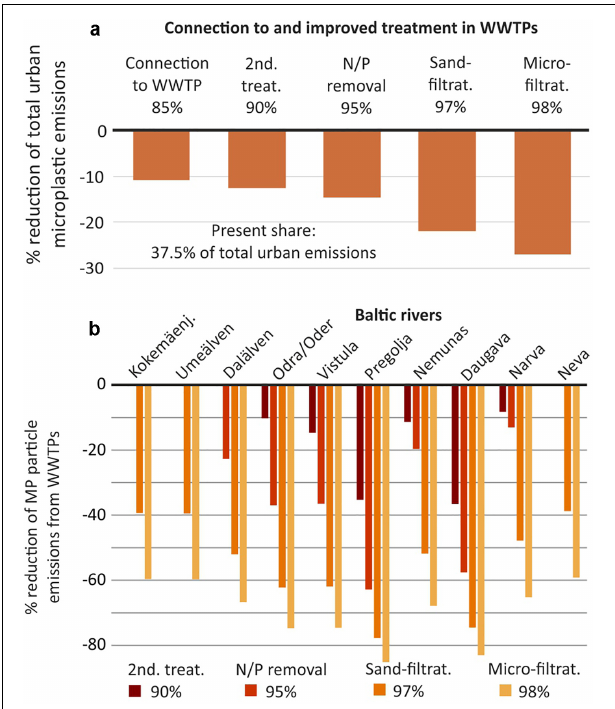
FIGURE 5 | (a) Relative micro-plastic particle emission reductions (floating and sinking fraction, size class 20–500 µ m) resulting from the assumption that all sewage water in the Baltic catchment is processed in a basic treatment plant (WWTP) with a micro-plastics cleaning efficiency of 85%, that all are connected and the WWTPs possess a secondary treatment with a 90% cleaning efficiency and that a better treatment is applied, reducing the micro-plastics loads by 95, 97, and 98%. (b) Relative micro-plastic particle emission reductions from WWTPs (floating and sinking fraction, size class 20–500 µ m) in 10 different Baltic river